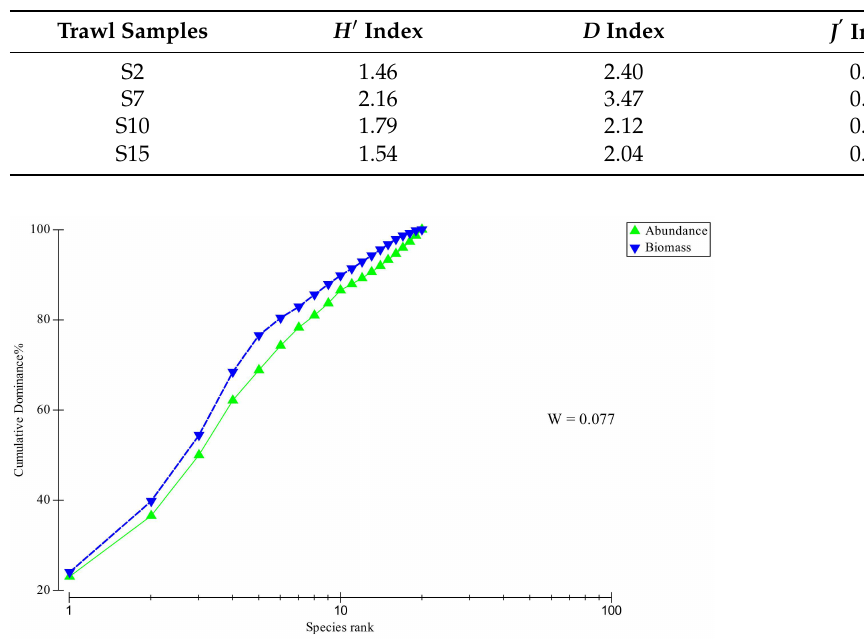
Table 4. Fish community parameters of each trawl samples.